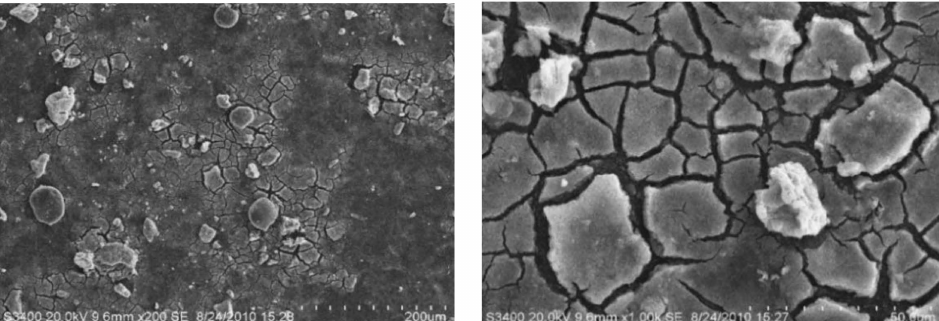
Figure 8. SEM photos of used UF